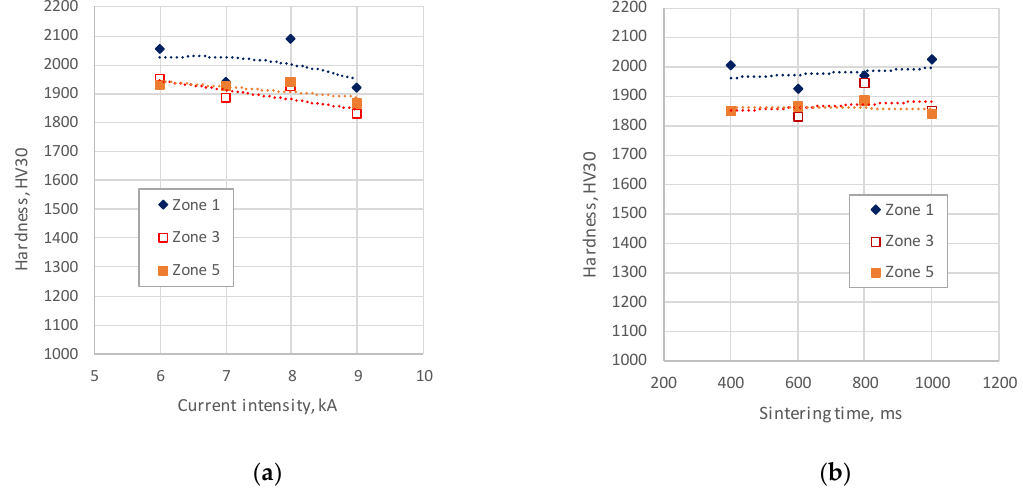
Figure 5. MF-ERS compacts hardness at zones 1, 3 and 5 as a function of ( a ) current intensity (experiences carried out with 600 ms), and ( b ) sintering time (experiences with 9 kA). Dotted lines are the trend lines of the different series.